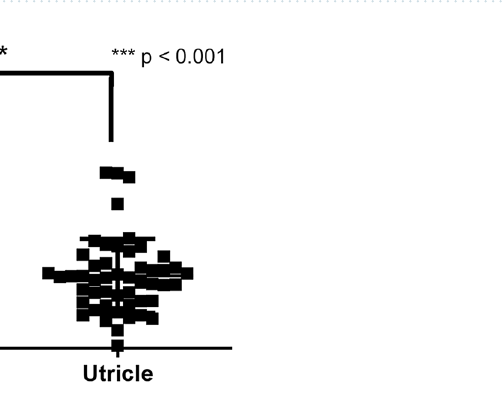
Figure 3. The ratio of endolymphatic hydrops (EH) measured in the saccule and utricle of the vestibule on